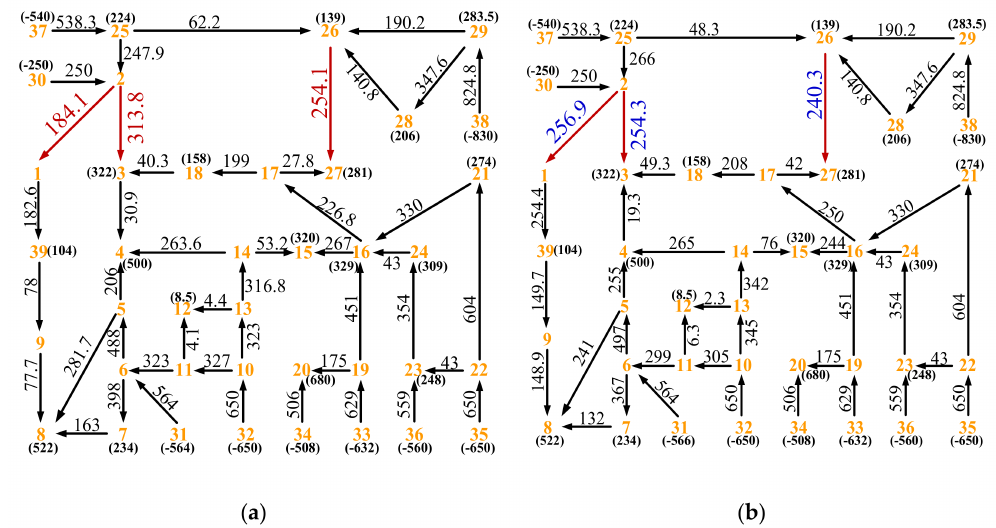
Figure 13. The active power flow distribution of the IEEE 39 bus system with ST or HVST compensation. ( a ) With ST compensation ( U sN = 0.15 pu); ( b ) With HVST compensation ( U sN = 0.15 pu).